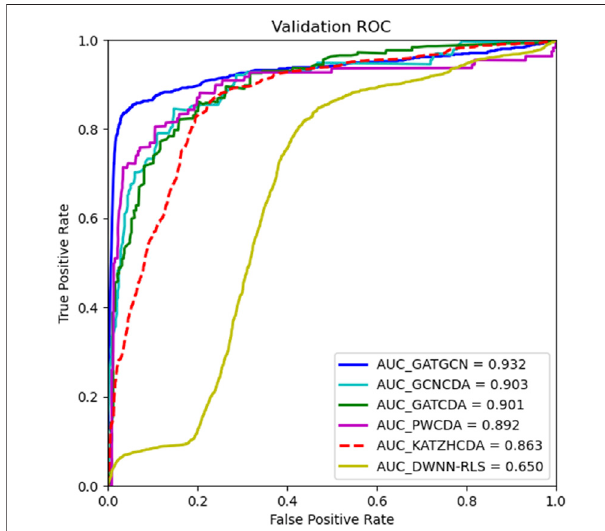
FIGURE 7 | Comparison results of various prediction models under fi ve- fold cross-validation.